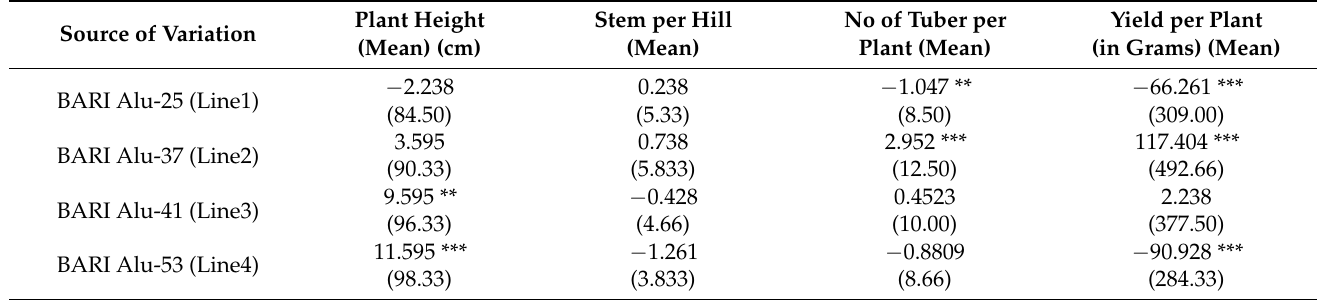
Table 5. Effects of General Combining Ability (GCA) for yield and yield characteristics grown in BSPC during the 2020–2021